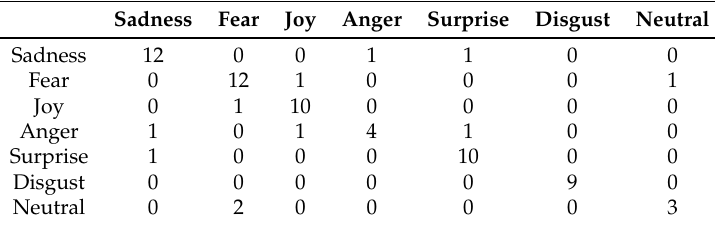
Table A27. A10 actor confusion matrix from the Emo-DB in the third